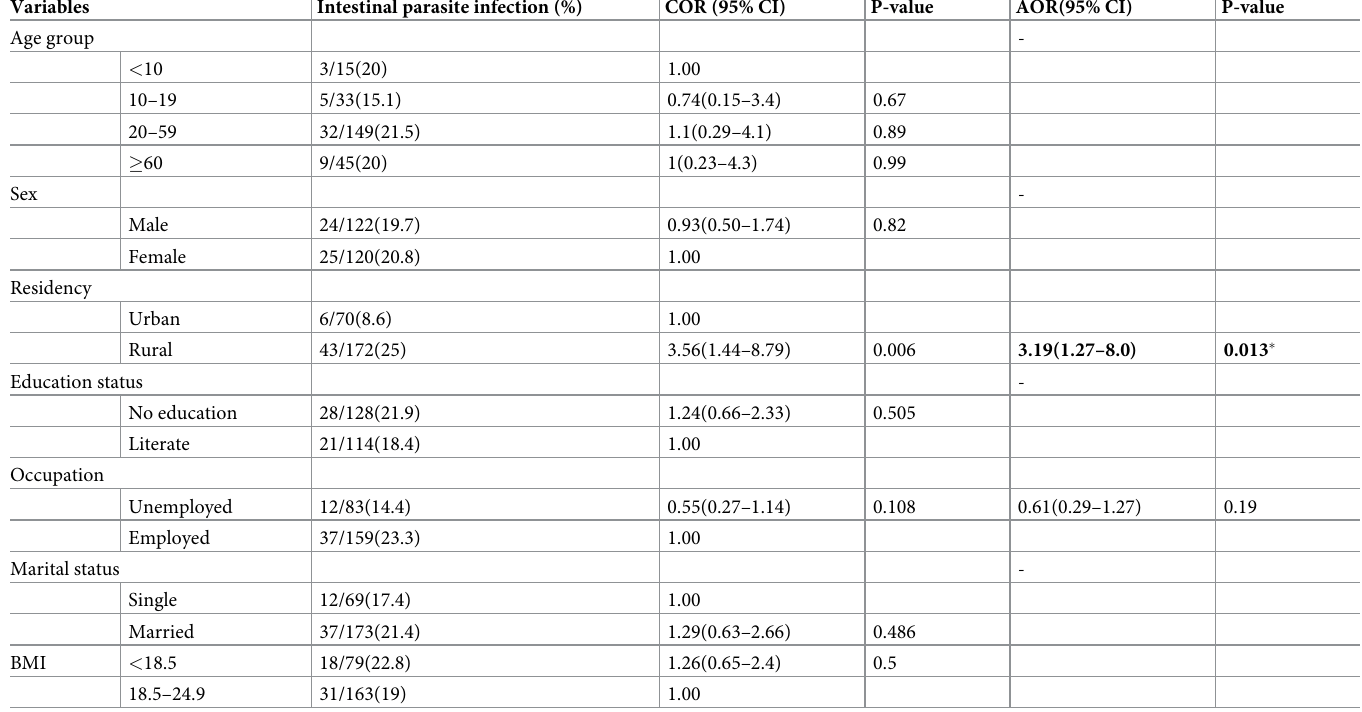
Table 3. Associated factors for intestinal parasitosis among PTB suspected patients attending Kuyu General Hospital, North Shewa, Oromia, Ethiopia, 2020 (n =